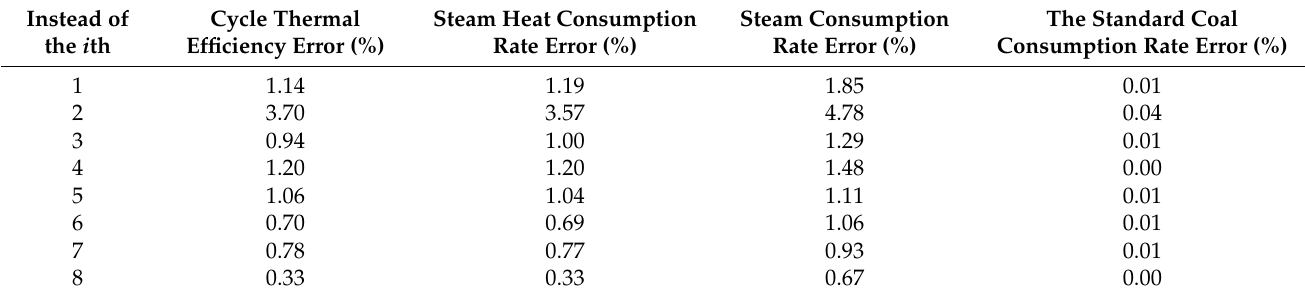
Table 3. Economic errors of replacing all levels under total variable conditions.